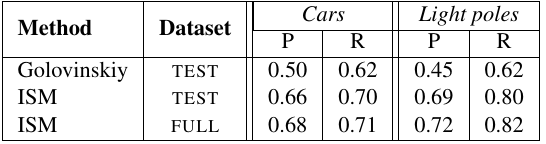
Table 1: Comparison between (Golovinskiy et al., 2009) and the proposed method (denoted as ISM, including both modified SIs and the height weight) in terms of [P]recision and [R]ecall. TEST bined training and test